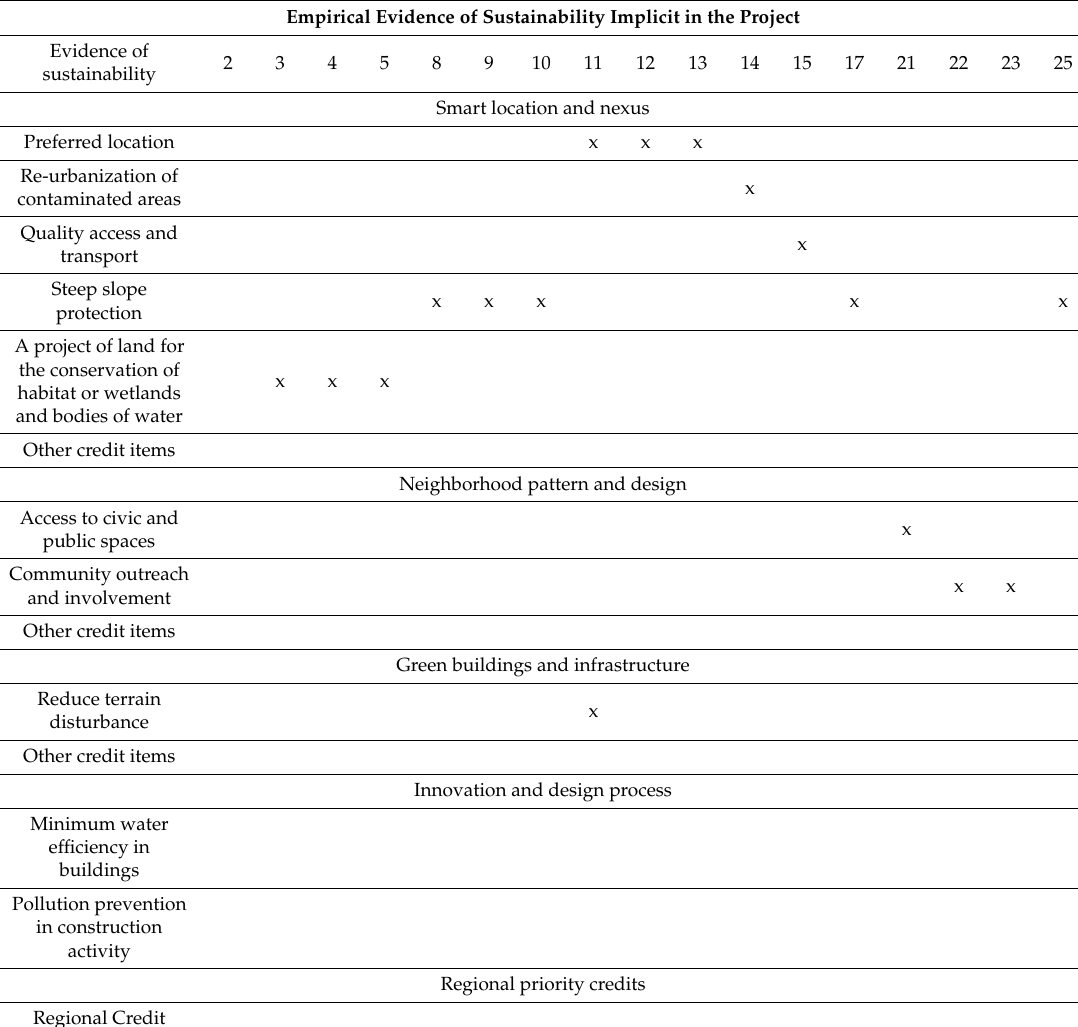
Table 5. Correlation of sustainability: credit